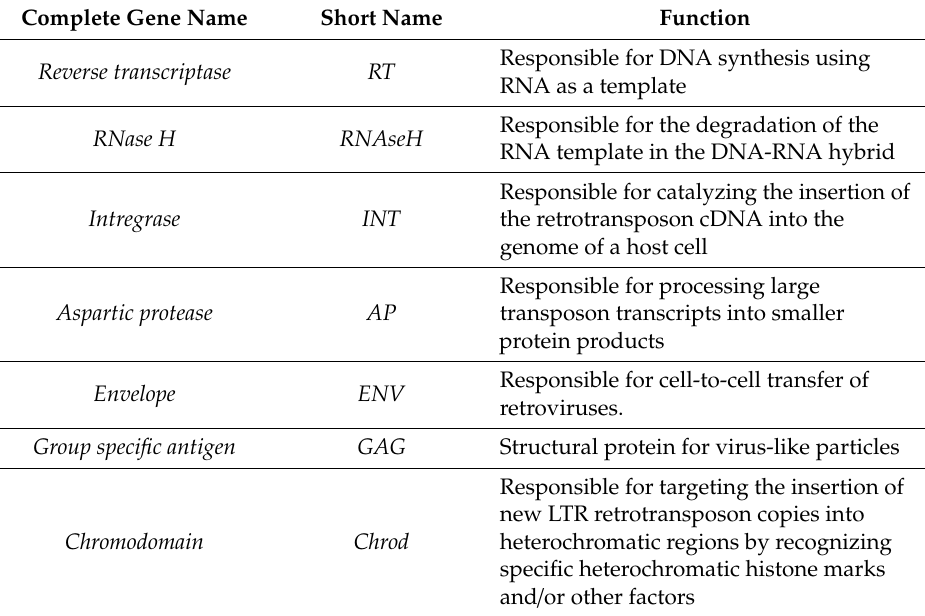
Table 1. Transposable element domains and their function in the replication mechanism. Adapted from [6,55]. LTR, long terminal